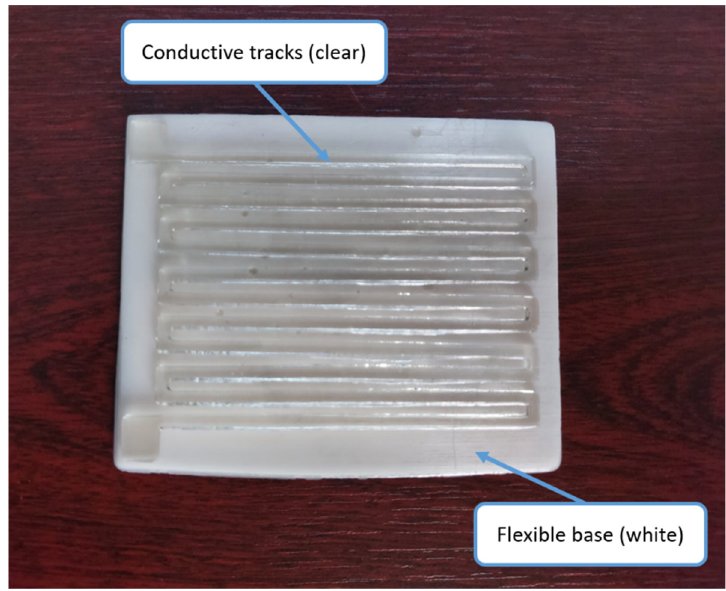
Figure 4. Strain sensor fabricated in an SLA-based 3D printer.